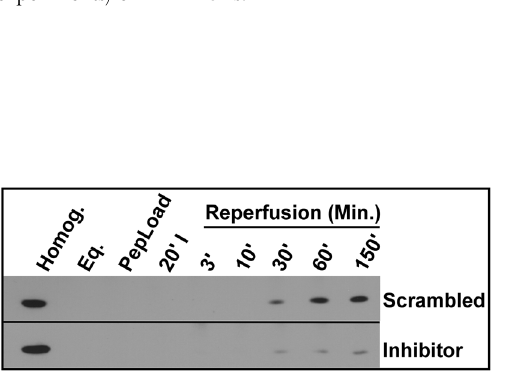
Figure 5. The d PKC-dF 1 Fo interaction inhibitor reduces cardiac troponin I (cTnI) release when perfused into Langendorff hearts. Experimental details were as described in the legend to Figure 4 except that during the peptide loading phase 50 nM concentrations of the scrambled sequence (inactive) control peptide or the d PKC-dF 1 Fo interaction inhibitor peptide were administered to hearts for 1 hr. Effluents were collected and Western blot analyses for cTnI were conducted. The left-most lane contains rat left ventricle homogenate used as a positive control for cTnI immunoreactivity. The remaining groups are described in the legend to Figure 4. Results shown are typical of the responses of 3 independent rat hearts in each peptide treatment